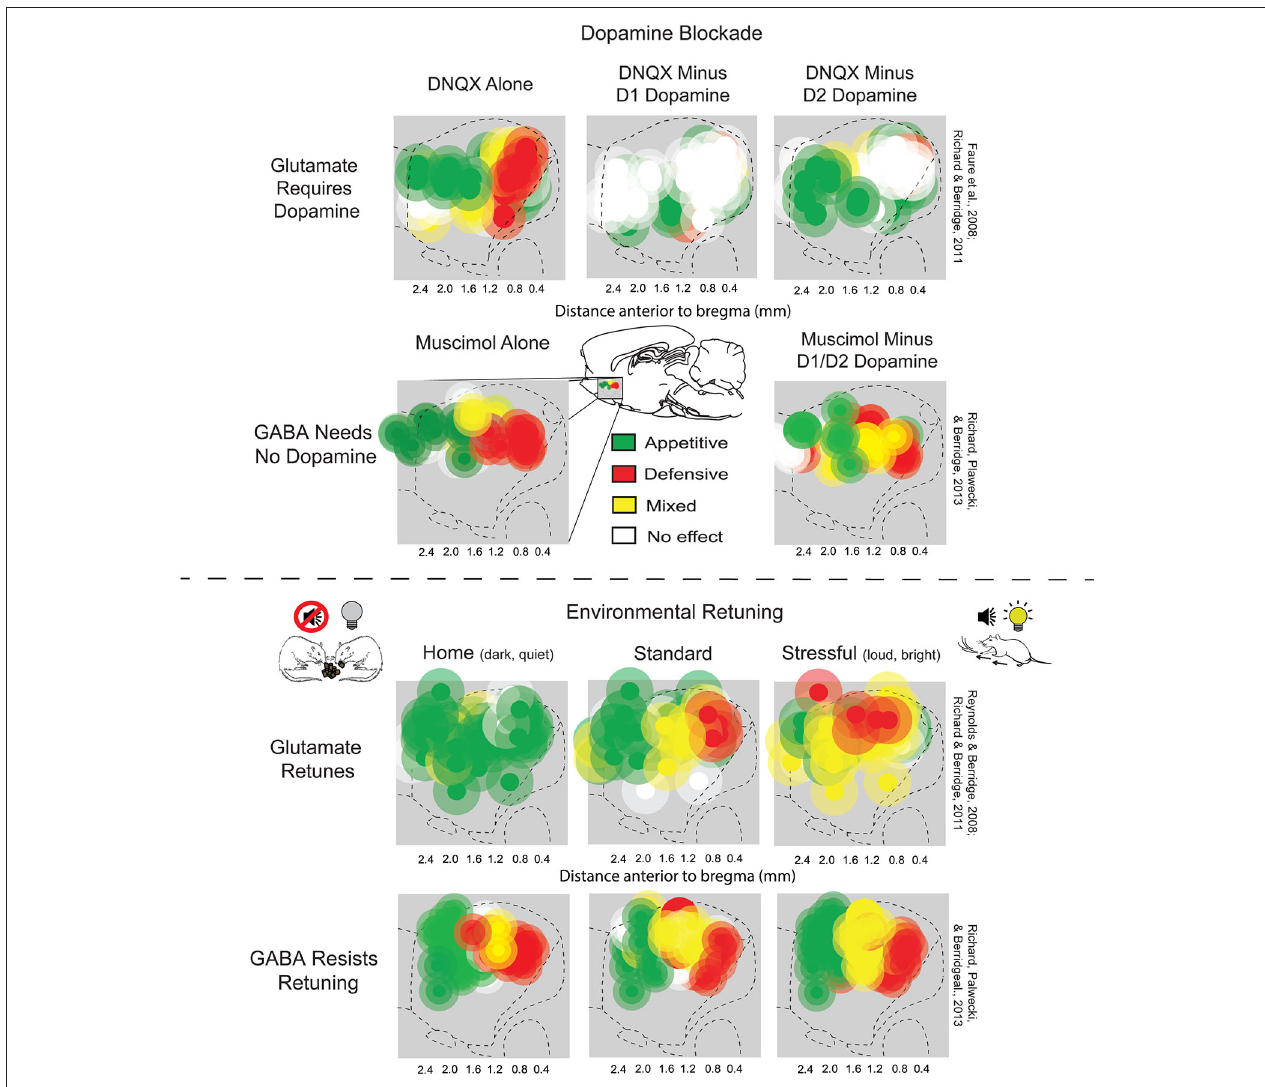
contrast, a stressfully loud and bright environment expanded DNQX-generated defensive behaviors into rostral regions of NAc shell, and suppressed fearful reactions (top right), relative to standard laboratory conditions (top middle). Muscimol microinjections in NAc shell generated eating and fear at similar sites to DNQX, but was not shifted by environmental ambience of home (bottom left), standard (bottom middle), or stressful test conditions (bottom right). Sites are colored as producing appetitive behavior (green sites), defensive behavior (red sites), or mixtures of both behaviors (yellow). Green symbols represent at least a 200% increase in food intake, red symbols represent at least a 500% increase in defensive treading or another defensive reaction (distress vocalization, escape attempt or biting when rat was touched), and yellow symbols represent a combination of the eating and defensive criteria (adapted from Richard et al.,